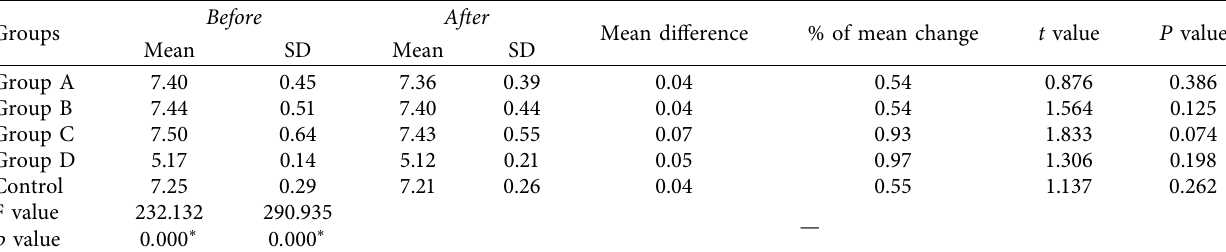
Table 3: Left side masseter muscle duration before and after treatment.